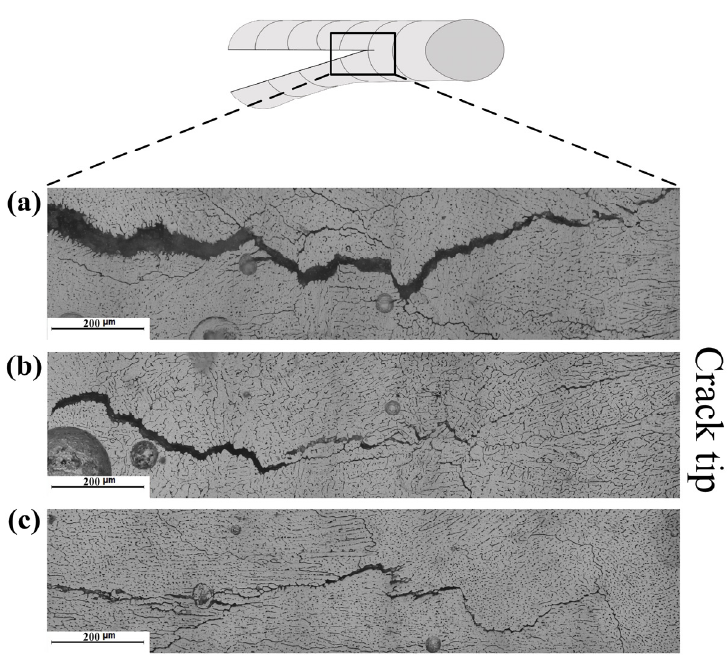
Figure 14. Crack tip of 7075 Al welded with 7055 Al as filler metal: ( a ) MIG mode; ( b ) CMT mode; ( c ) CMT+P mode.